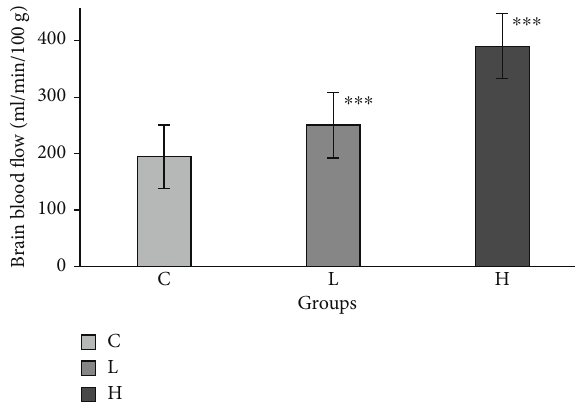
Figure 2: Quanti fi cation of cerebral blood fl ow using the microsphere method. C: control group receiving 0mg/kg 13-RA; L: low-dose group receiving 0.3mg/kg 13-RA; H: high-dose group receiving 0.5mg/kg 13-RA.